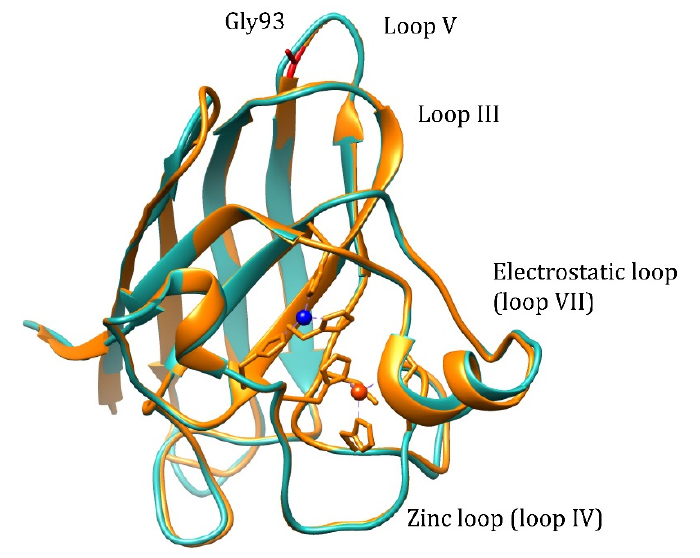
Figure 1. Structure alignment of the human wt Cu,Zn-SOD1 (light-blue, PDB: 2C9V) and G93A mutant (yellow, PDB: 2WKO). Cu 2+ ion: blue, Zn 2+ ion: